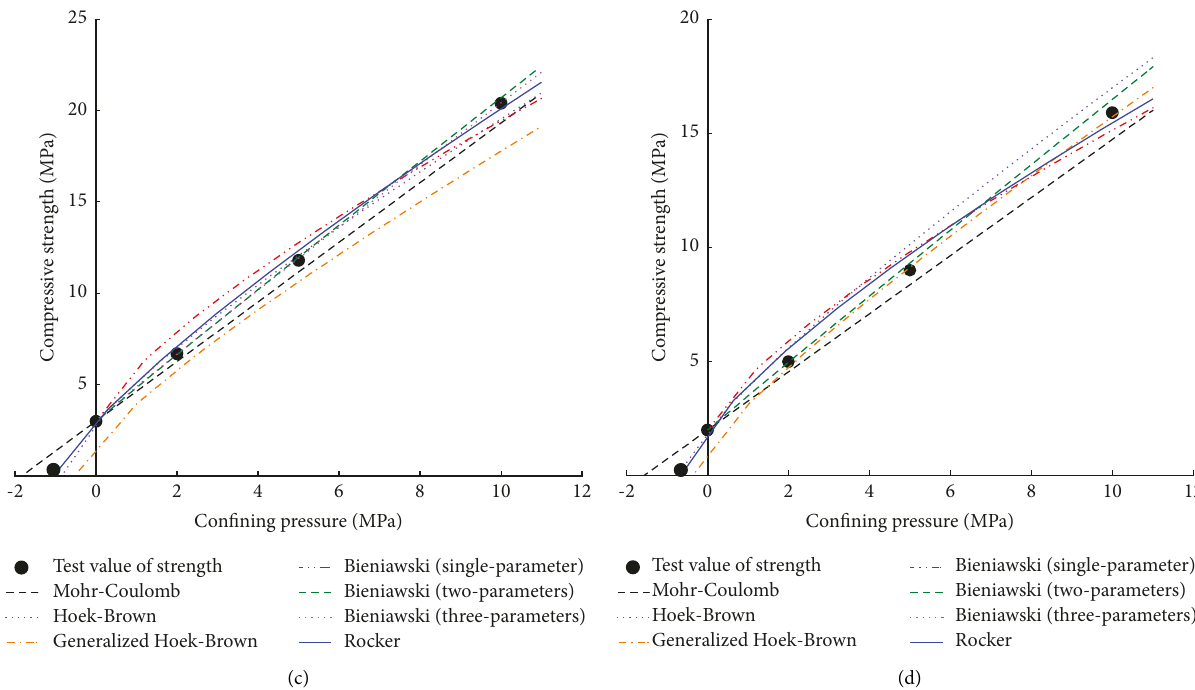
Figure 9: Strength criterion prediction curves of mudstone under different water content. (a) Water content: 0. (b) Water content: 10.1%. (c) Water content: 12.5%. (d) Water content: